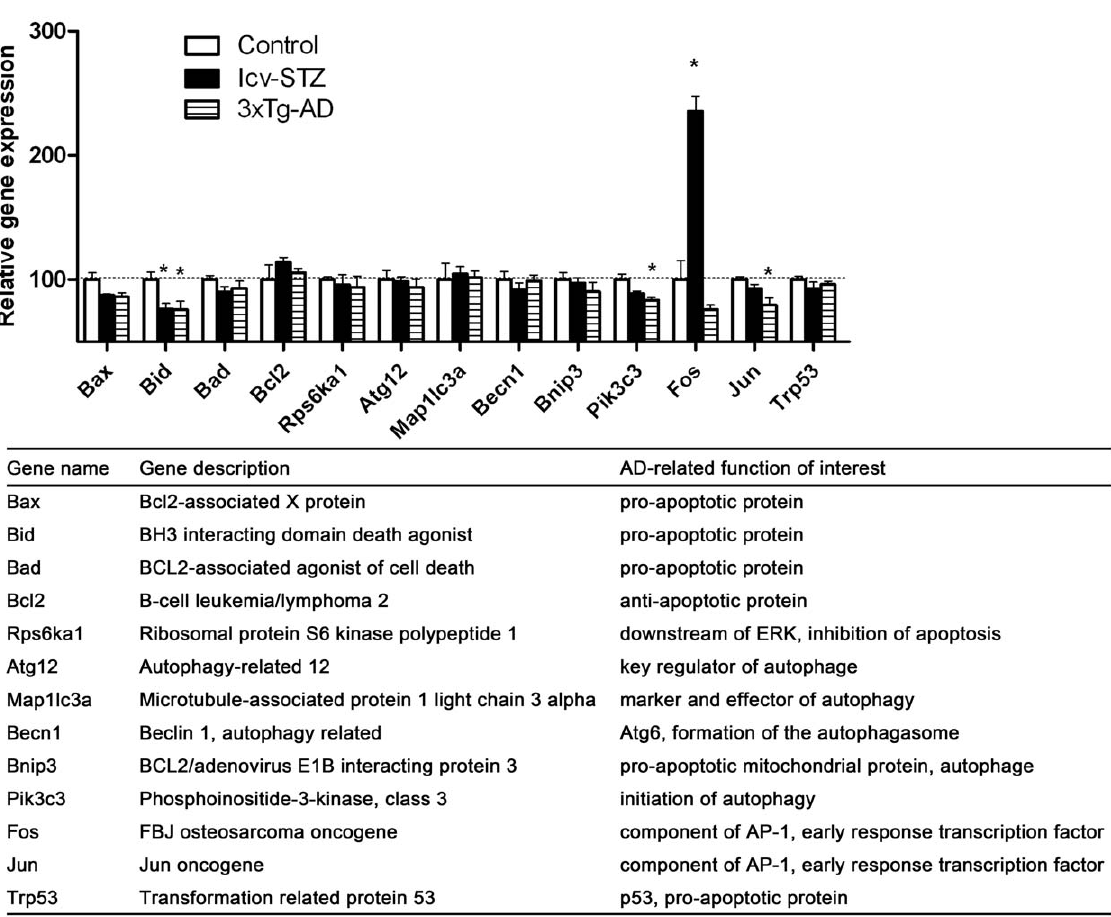
Figure 5. Expressions of apoptosis- and autophagy-related genes and transcription factors in the hippocampus.